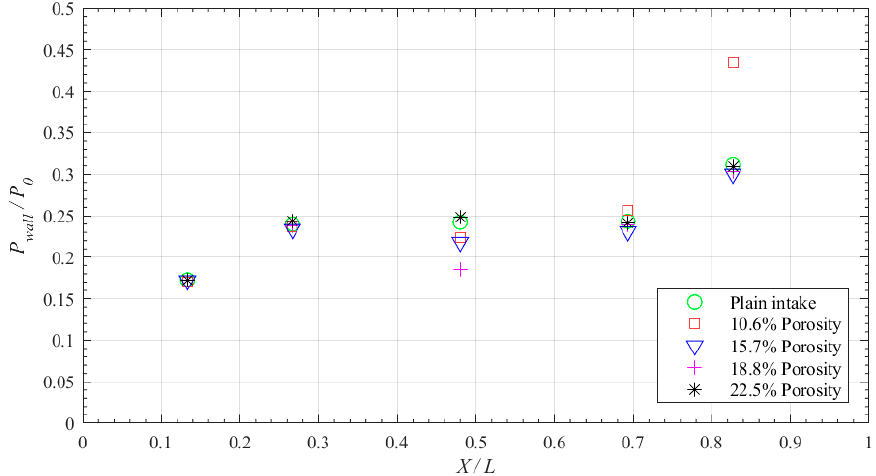
Figure 15. Static pressure variation along the intake-core due to wall ventilation at R c = 1.25.